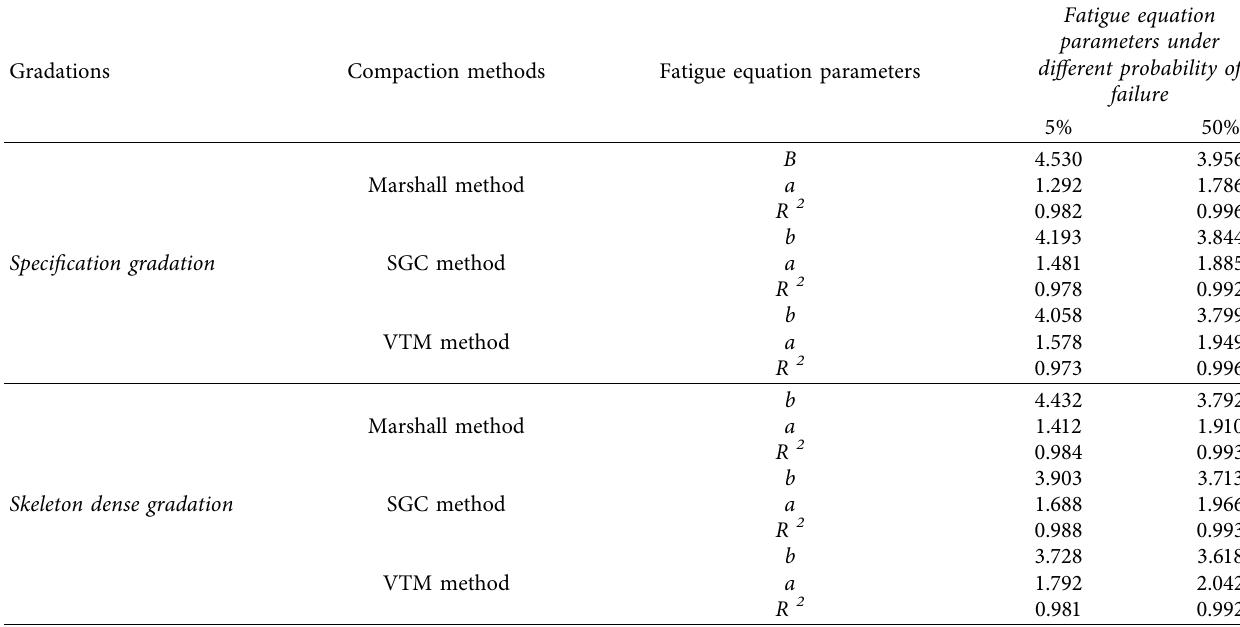
Table 11: Fitting results of different types of SMA-13